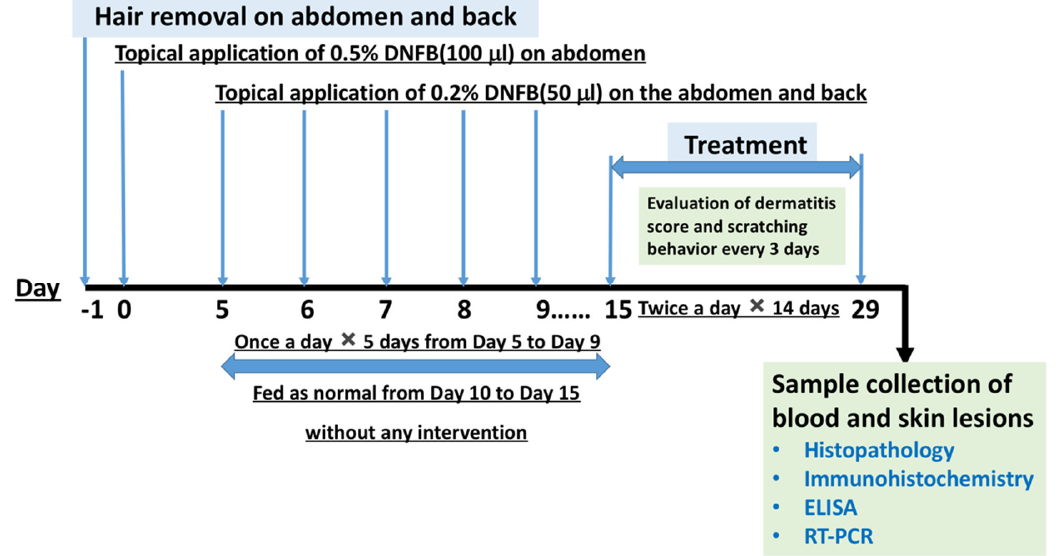
Figure 6. Experimental schedule for establishment of AD-like symptom model and treatment plan in BALB/c mice.